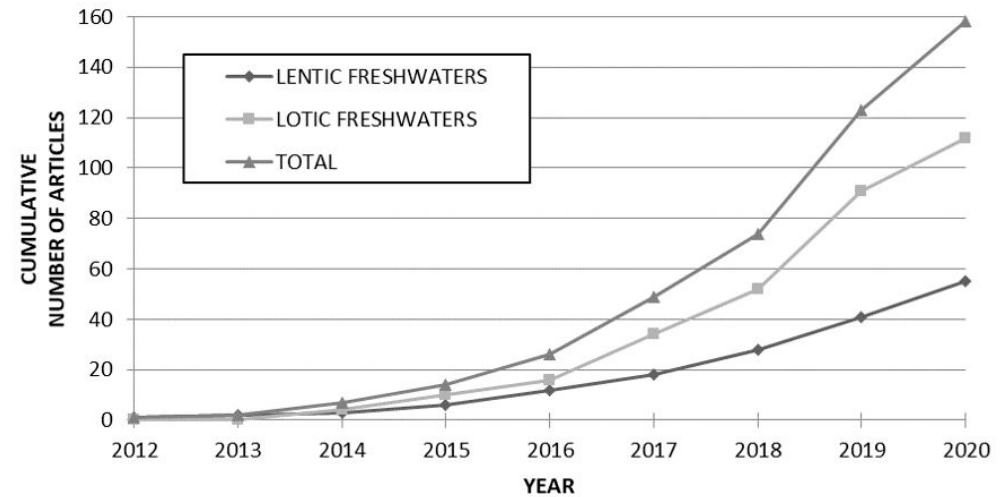
Figure 1. Number of articles published on the freshwater microplastics contamination updated to